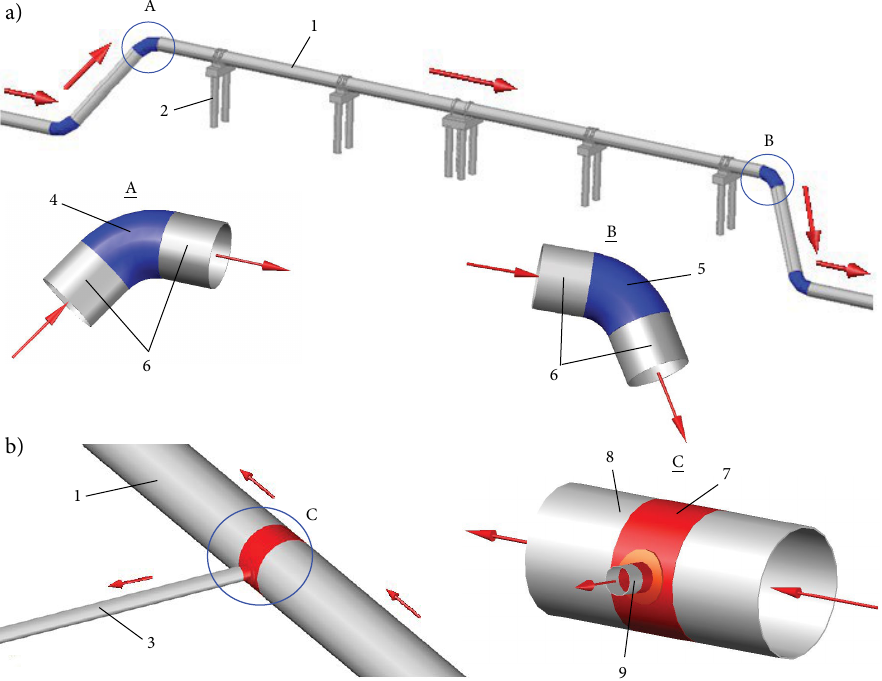
Figure 1. The locations of elbows and T-junction: a – above-ground crossing; b – branch from the main; 1 – gas main; 2 – support; 3 – branch; 4, 5 – elbow 60 ° 1420 × 28 mm; 6 – pipe 1420 × 21.5 mm; 7 –T-junction welded with